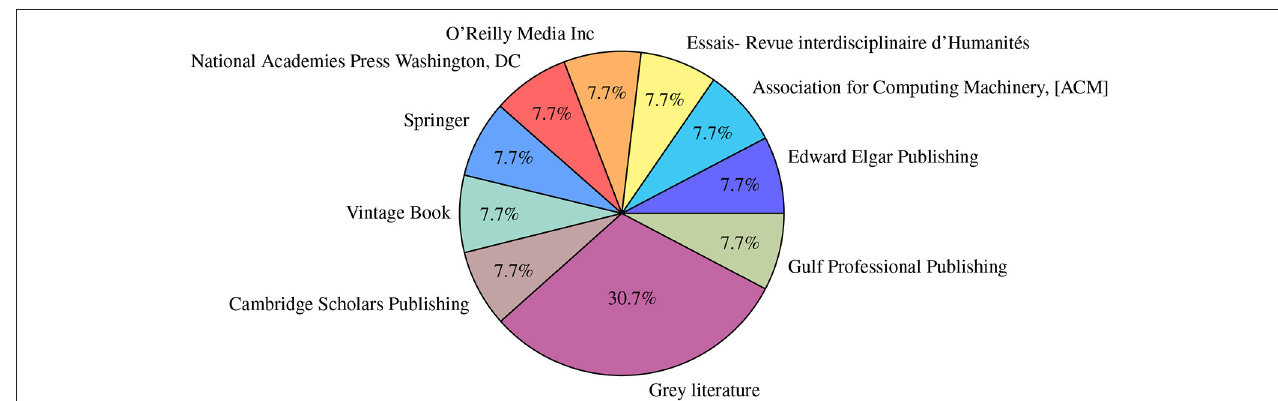
FIGURE 3 | Papers distribution—by